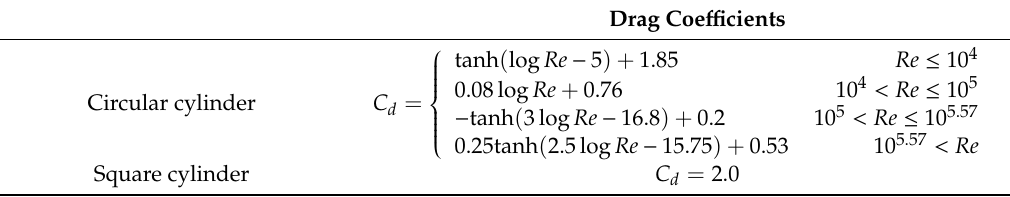
Re Figure 6. Variation of C d of square and circular cylinders with Reynolds number in the steady flow. C of square and circular cylinders with Reynolds number in the steady flow. Figure 6. Variation of d Table 3. Drag coe ffi cients of circular and square cylinders as functions of Re in steady flow. Table 3. Drag coefficients of circular and square cylinders as functions of Re in steady flow. Drag Coe ffi cients